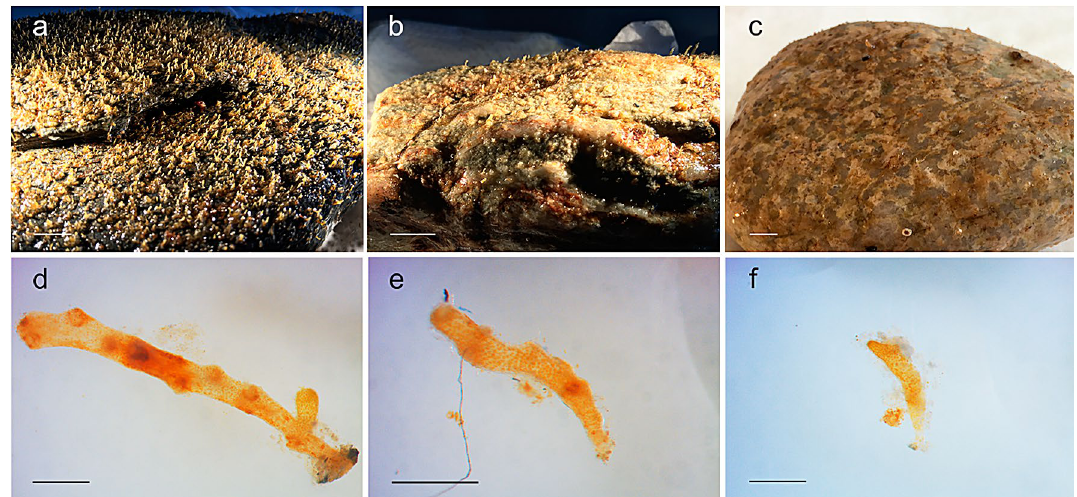
Figure 7. Top: Example of stones with recruits at month 3: ( a ) control, ( b ) nitrate and ( c ) glyphosate 0.5 µg/L. The horizontal scale bars represent 1 cm. Bottom: Recruits of Carpodesmia crinita at month 3 under different treatments: ( d ) control, ( e ) nitrate and ( f ) glyphosate 0.5 µg/L. Scale bars represent 0.5 mm.